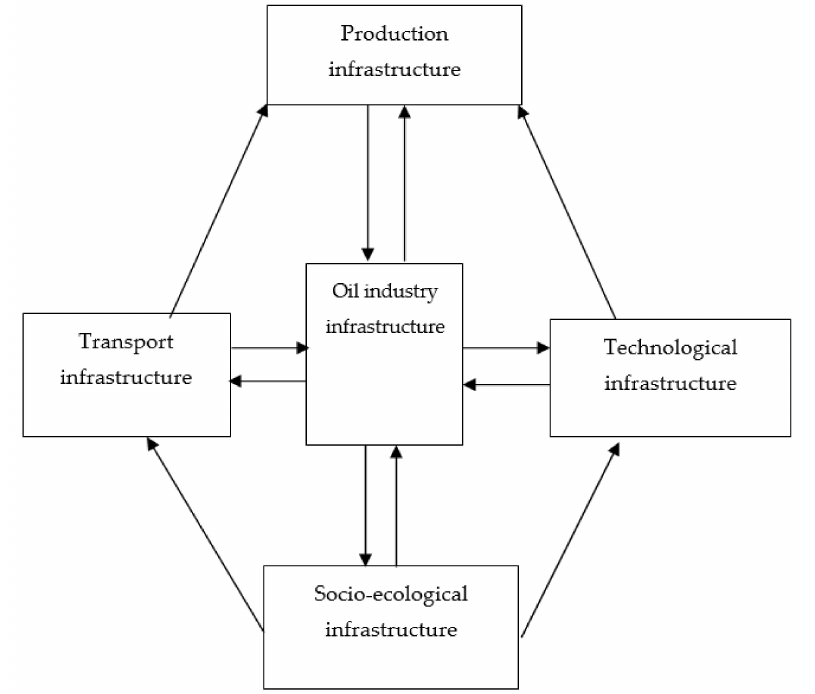
Figure 3. Strategic projections of the system of indicators for the development of oil industry